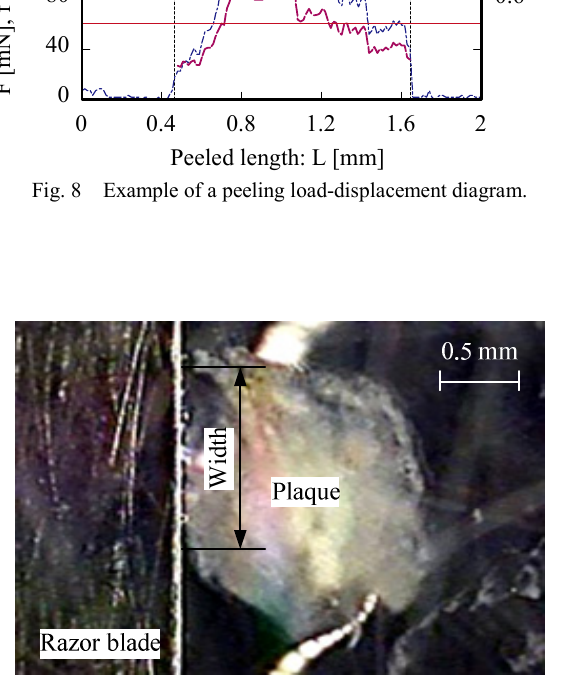
Fig. 9 Observation of the peeling